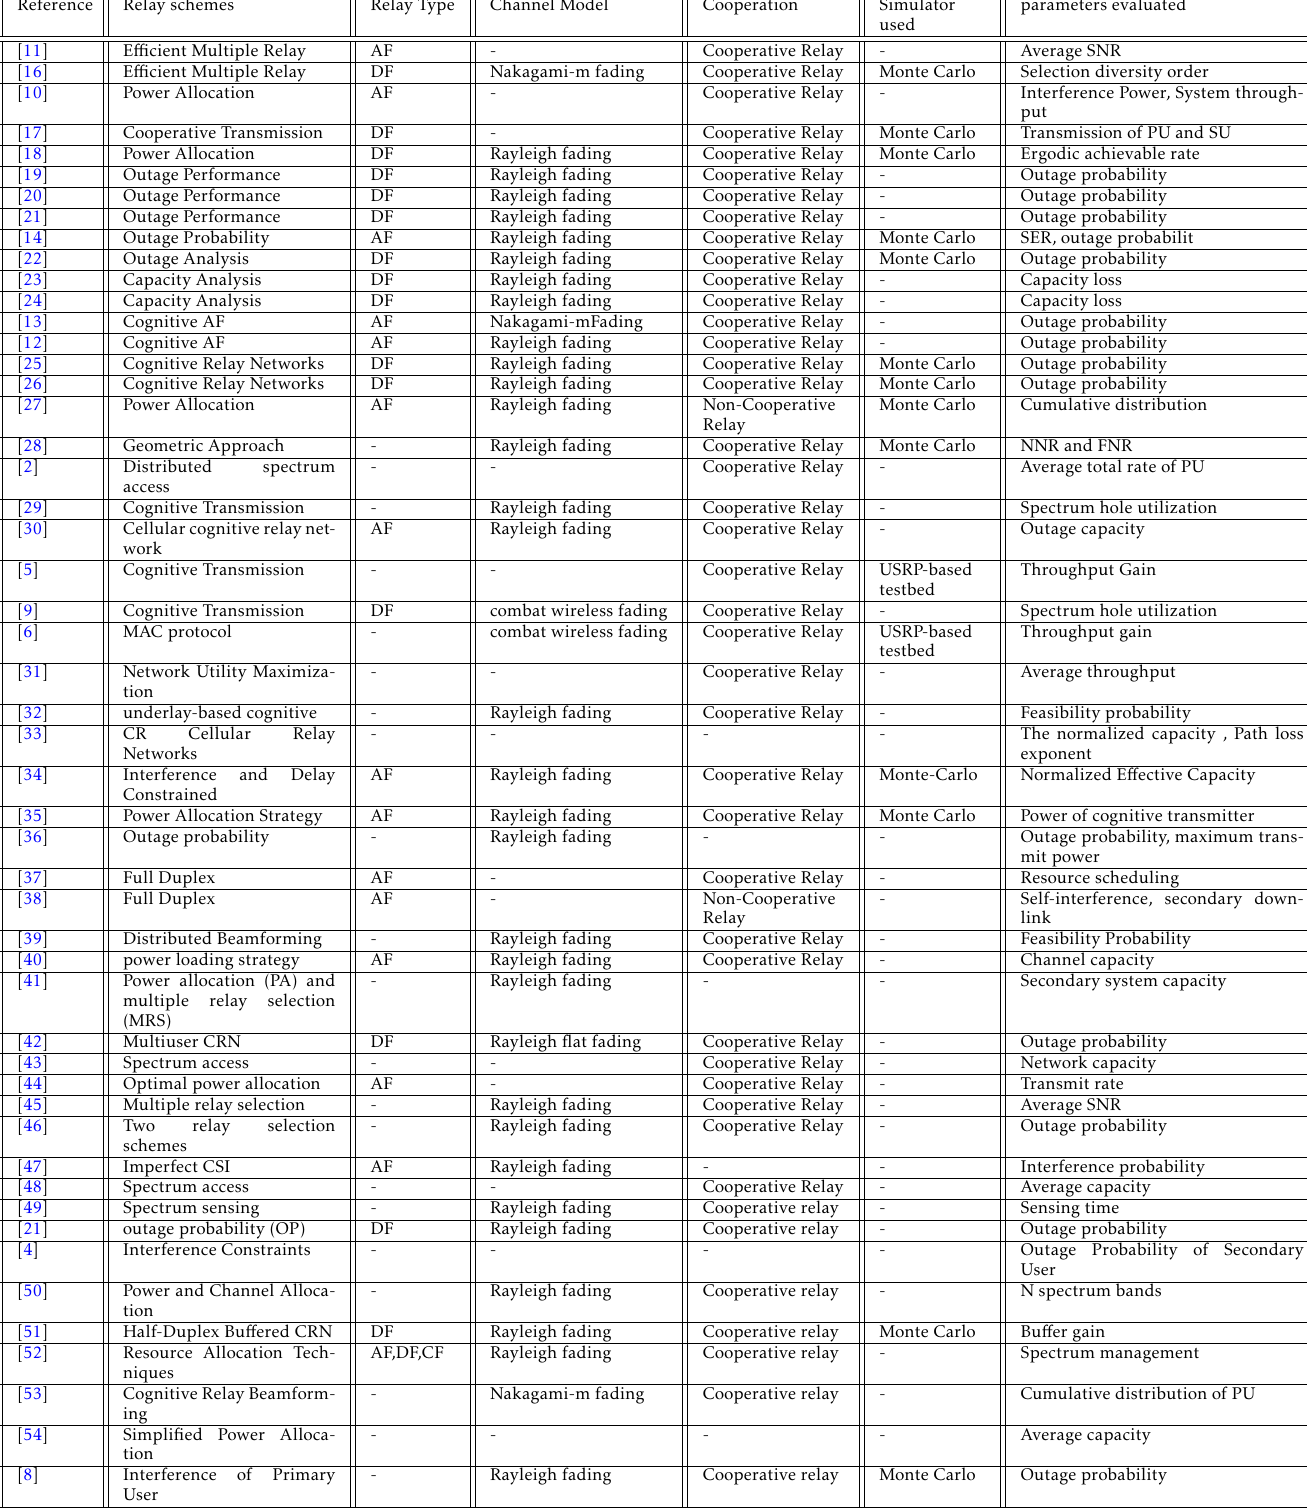
Table 1. Existing schemes of relaying in cognitive radio networks